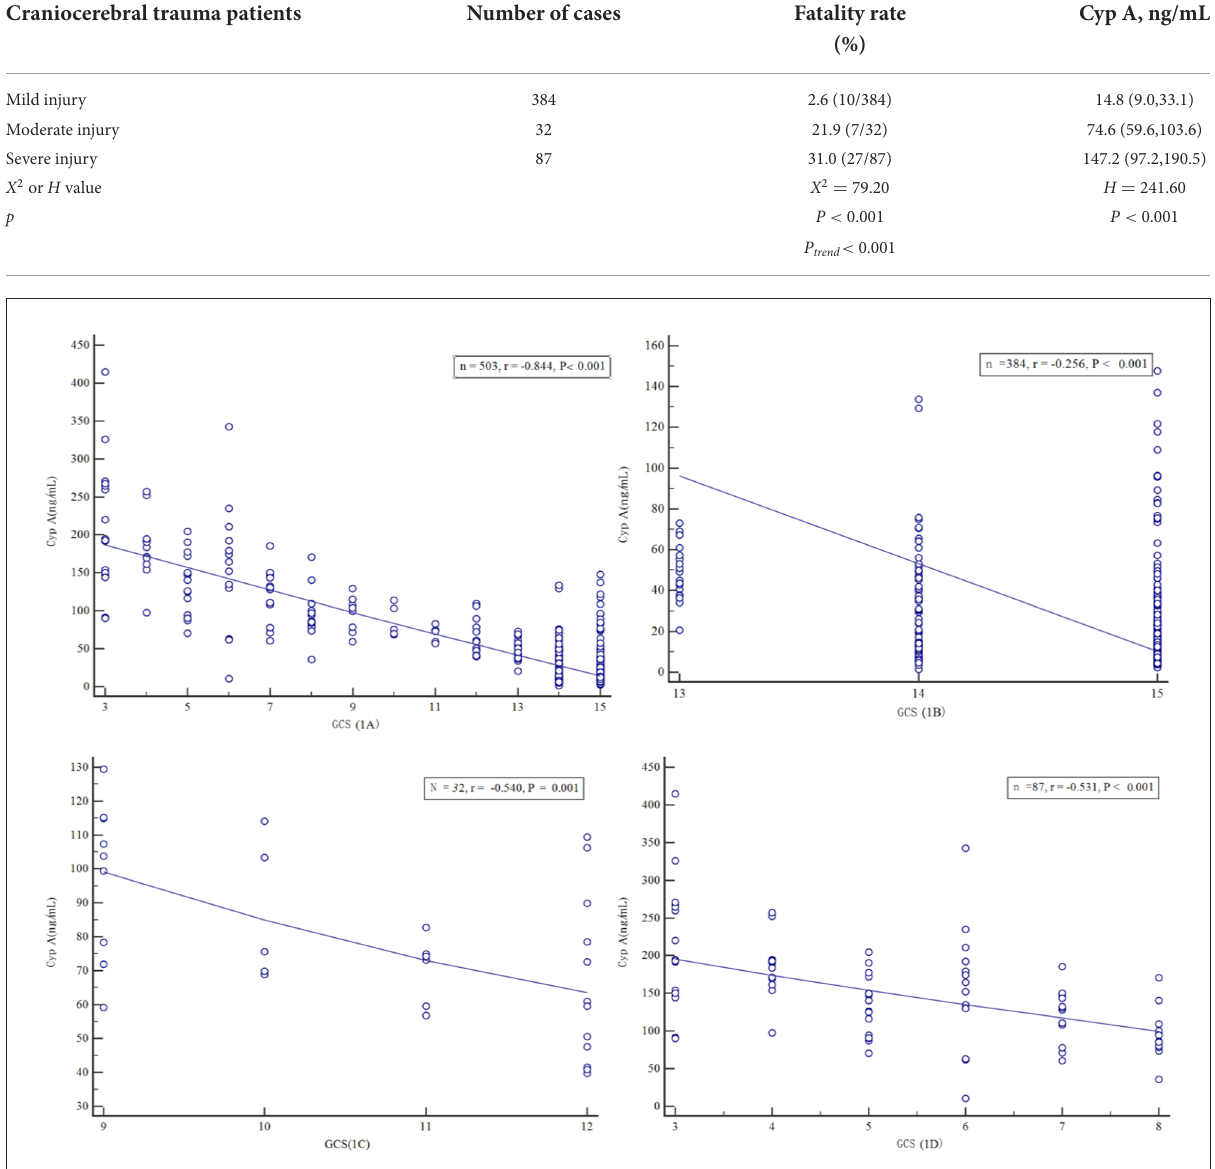
FIGURE1 Scatter plot of serum Cyclophilin A level versus Glasgow Coma Scale score, in all craniocerebral trauma patients (A), in mild craniocerebral trauma patients (B) , in moderate craniocerebral trauma patients (C) , in severe craniocerebral trauma patients (D) .